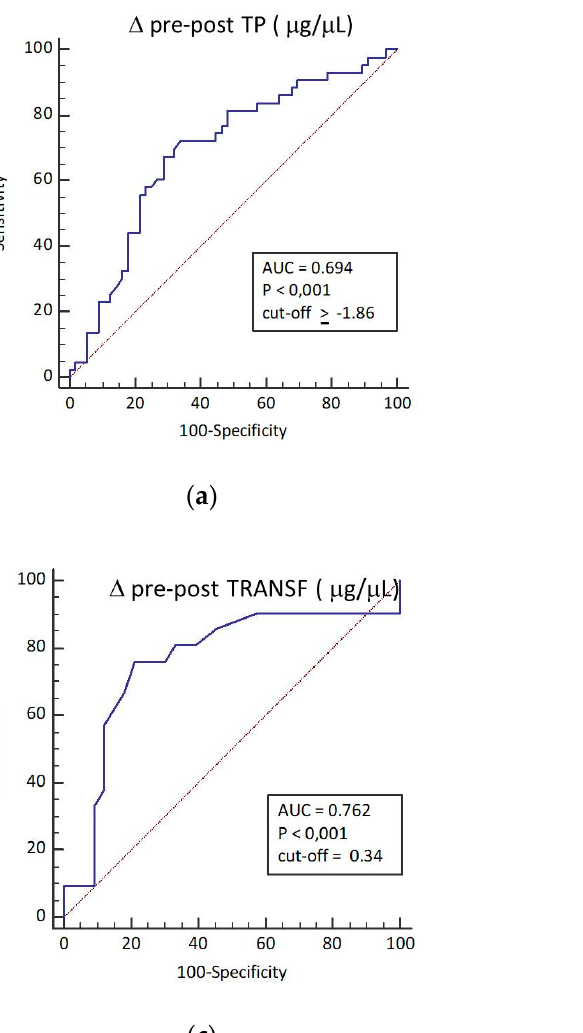
the curve (AUC) values and the cut-off values are listed in all panels, along with the p values, always statistically